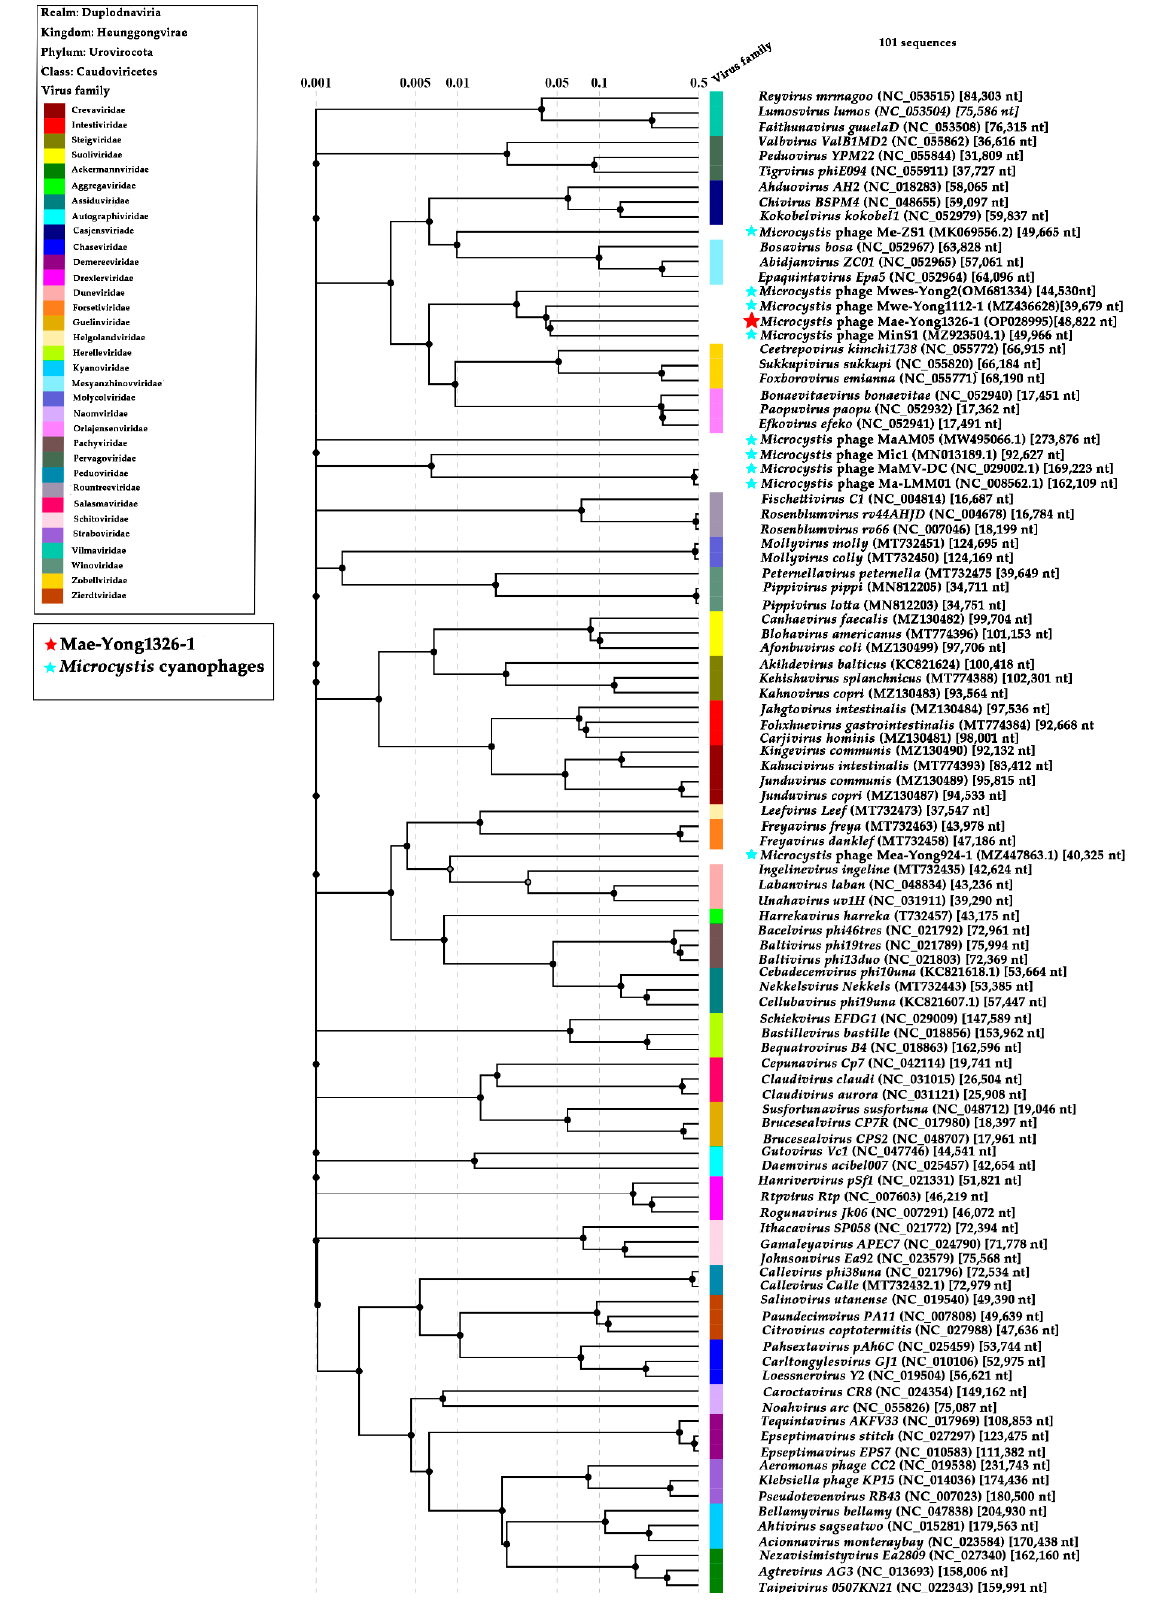
Figure 5. Phylogenetic proteomic tree of Mae-Yong1326-1, 9 reported Microcystis cyanophages, and 91 classified phages of the 33